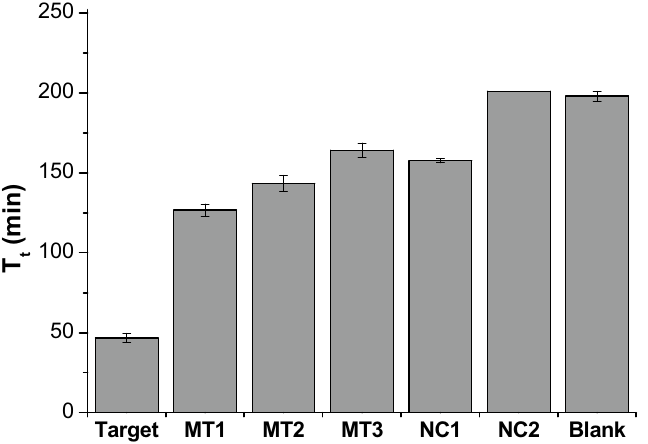
Figure 4. Specificity of the PHAmp reaction. The T t values for target DNA and nonspecific target DNAs including several base-mismatched DNAs (MT1, MT2, and MT3) and non-complementary DNAs (NC1 and NC2) were determined and compared. T t is defined as the time when the fluorescence signal reaches the threshold intensity (1000 a.u.).